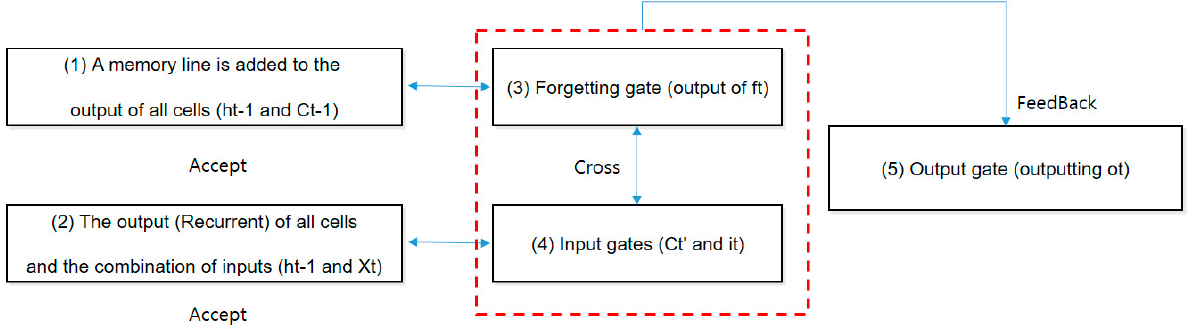
Figure 8. LSTM Gate Verification.